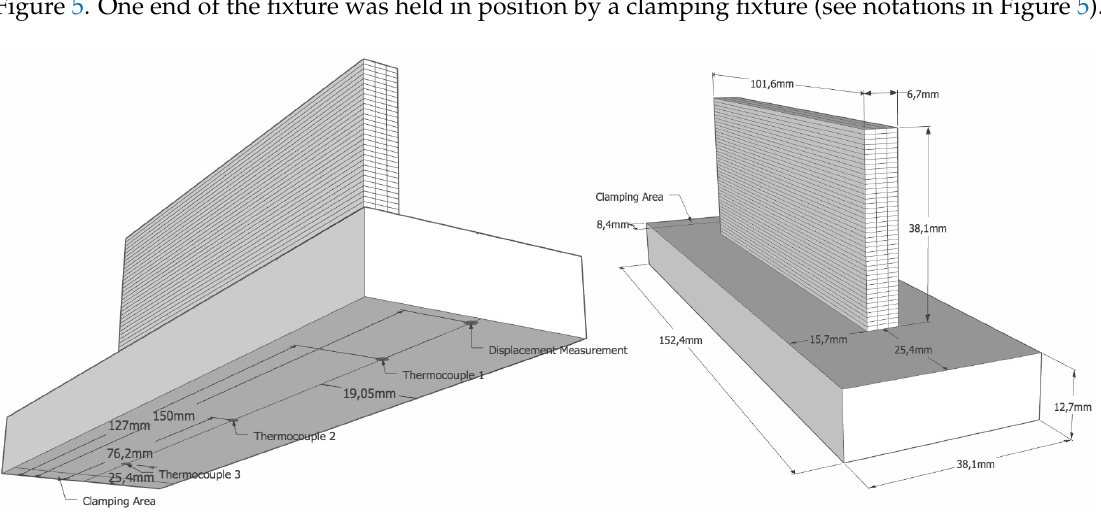
Figure 5. Dimensions of additive-manufacturing (AM) component.